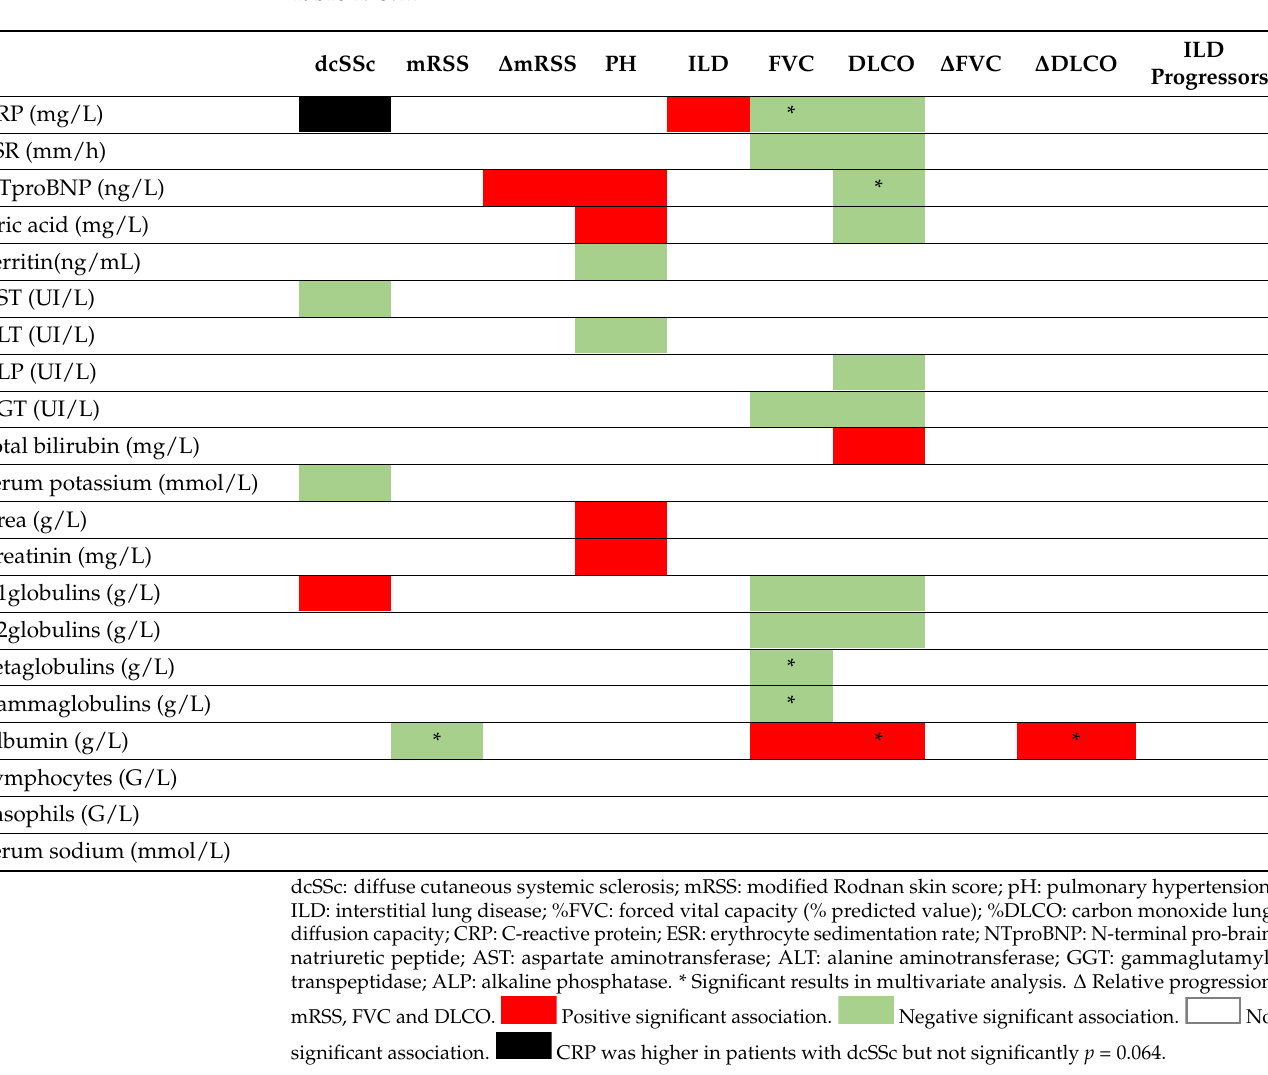
Table 4. Summary of the main results in univariate and multivariate analysis.